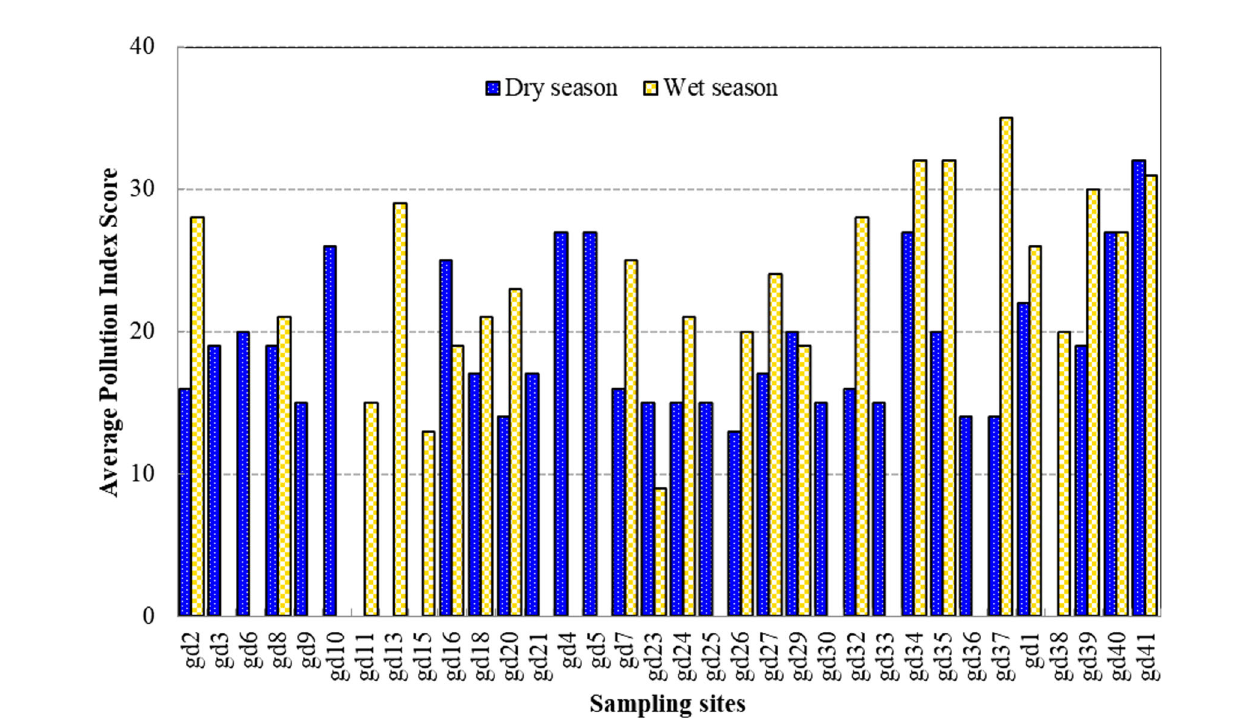
FIGURE 5 | The temporal and spatial variation of the algal genera pollution index score during the study period.